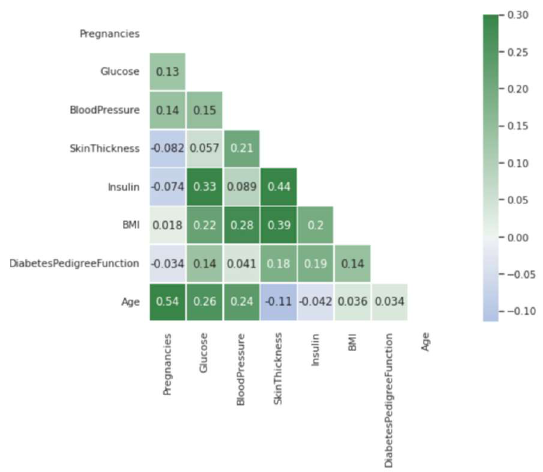
Table 2 : Model Accuracies for Heart (After Parameter Tuning) Figure 5 : Diabetes Co-relational Matrix